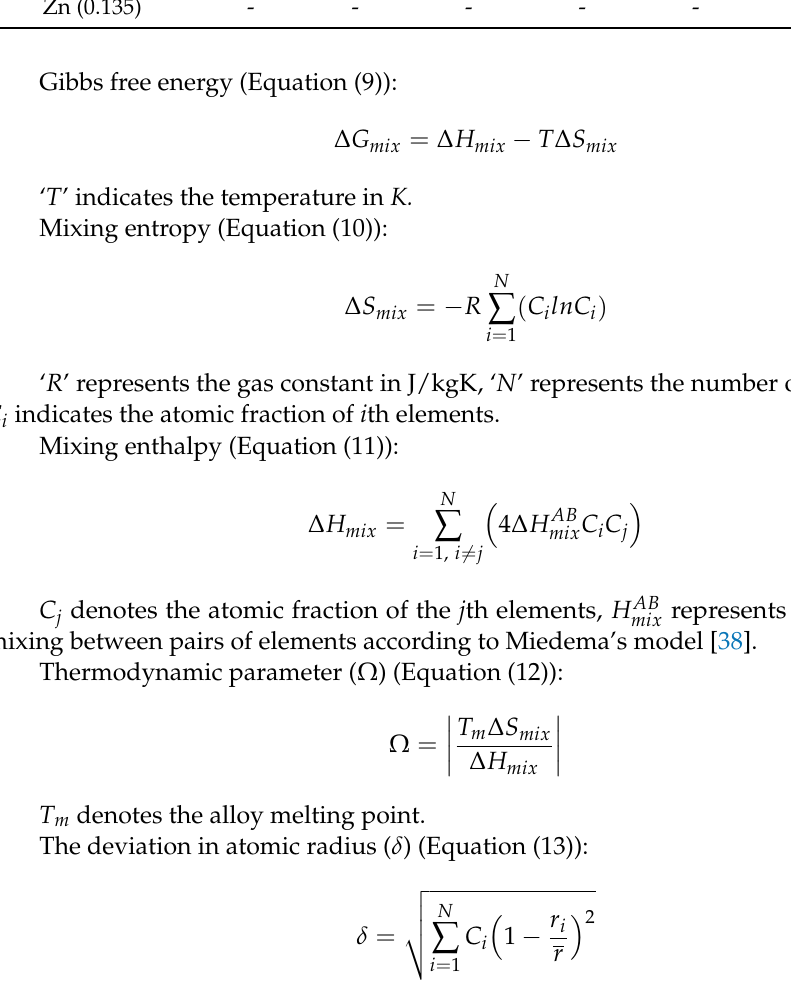
Table 6. Calculated physio-chemical and thermodynamic values for the three developed nanostructured HEAs. Equiatomic Alloy Composition FeCrCuMnTi